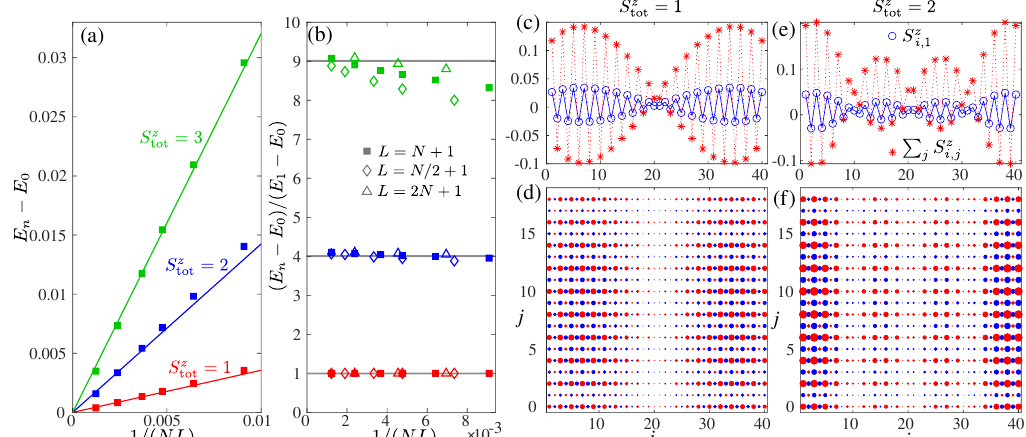
Figure 6: (Color online) Magnetic excitations on a comb lattice with an odd number (cid:28) 1. (a) Finite size scaling of the energy difference of sites per tooth in the limit J bb between the singlet ground-state and the lowest triplet (red), quintuplet (blue) and septuplet (green) states. Lines are linear fit of the singlet-triplet gap as a function of 1 / ( N L ) multiplied by the expected structure of conformal tower n = 1,4,9. (b) The conformal tower of states extracted as a ratio of the gaps for each fixed size of the comb. Results for n = 1 are trivial and shown for completeness. (c)-(f) Distribution of local magnetization on a comb lattice with L = 19 and N = 40. (c), (e) Local magnetization on the backbone (blue circles) and total magnetization of a teeth as a function of tooth index i (red stars). (d), (f) Local magnetization, with the size of the circles proportional to the absolute value of magnetization; red and blue colors indicate positive and negative signs of magnetization